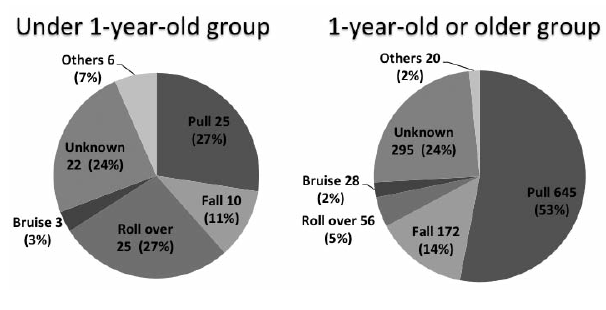
Figure 2. Age distribution of all patients with pulled elbow. There were a mean age of injury at six months under one year old, and at two years over one year old, and was consistent for both boys and girls.